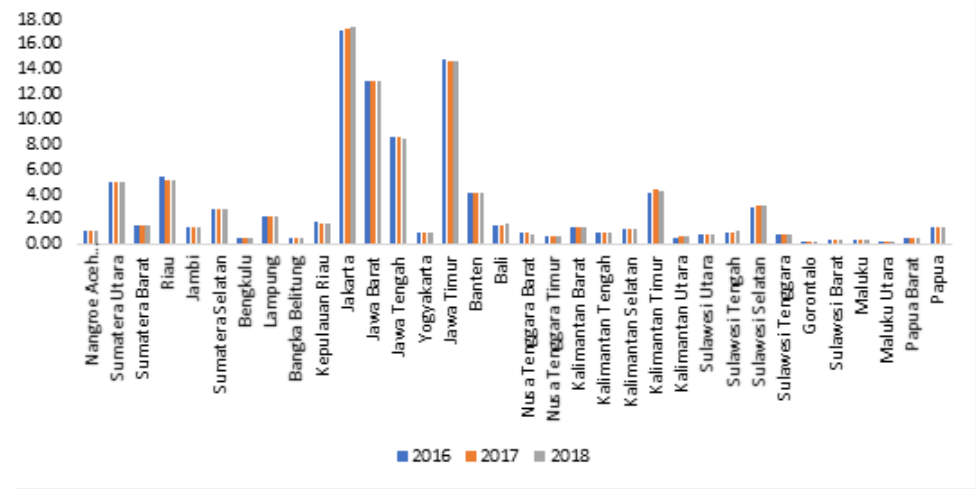
Figure 1: Share of GRDP on GDP